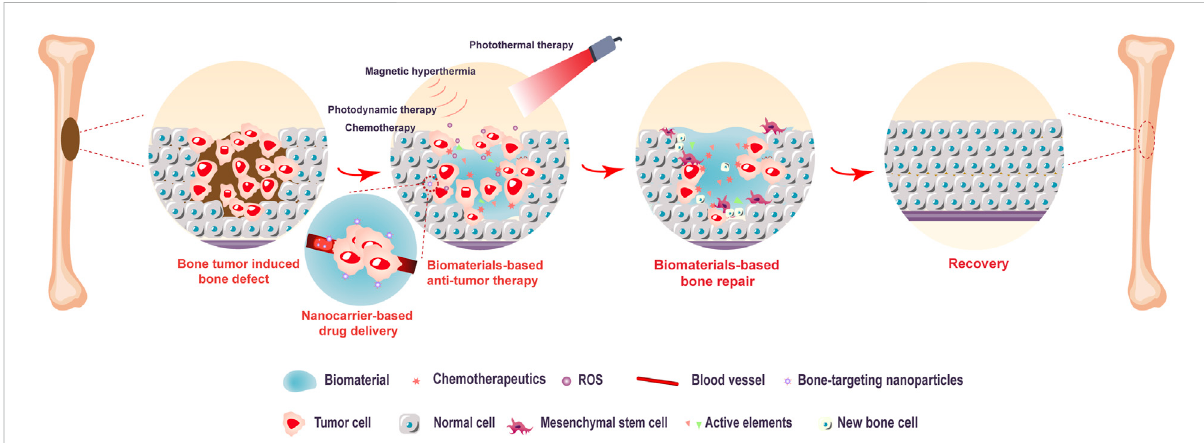
FIGURE 2 Biomaterial-based bone tumor and bone repair scheme. The biomaterial-based strategy (including targeted chemotherapy, photothermal therapy,photodynamictherapy,andmagnetichyperthermia)demonstratesahighanticancereffectintheearlystage.Additionally,biomaterialswith great osteoinductivity support the attachment, proliferation, and differentiation of mesenchymal stem cells in bone tissue